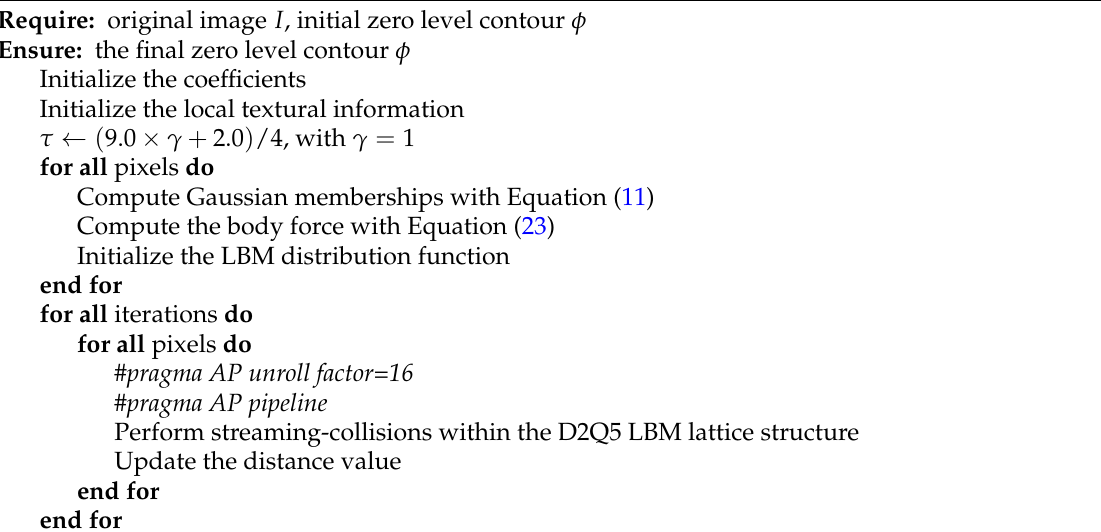
Algorithm 3 Pseudocode of the Loop Unwinding (LU)-optimized implementation.